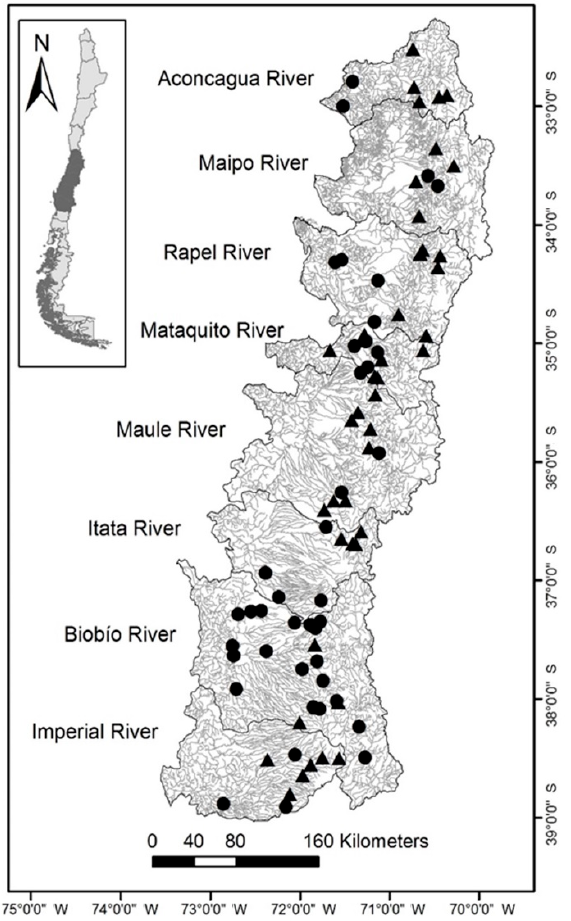
Figure 1. Location of sampling sites (triangles and dots) in the eight river basins that make up the study area. Dots correspond to sites with pool and riffles, whereas triangles correspond to sites with only riffles.